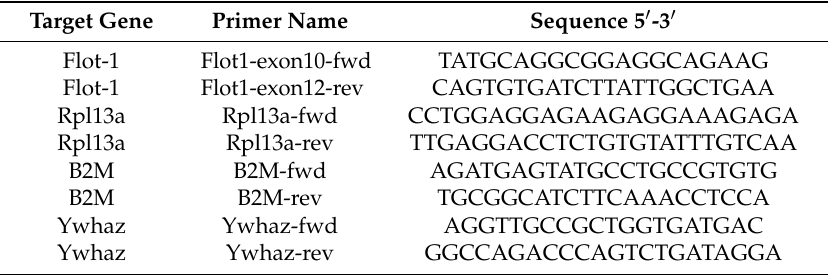
Table 3. Sequences of the qPCR primers.